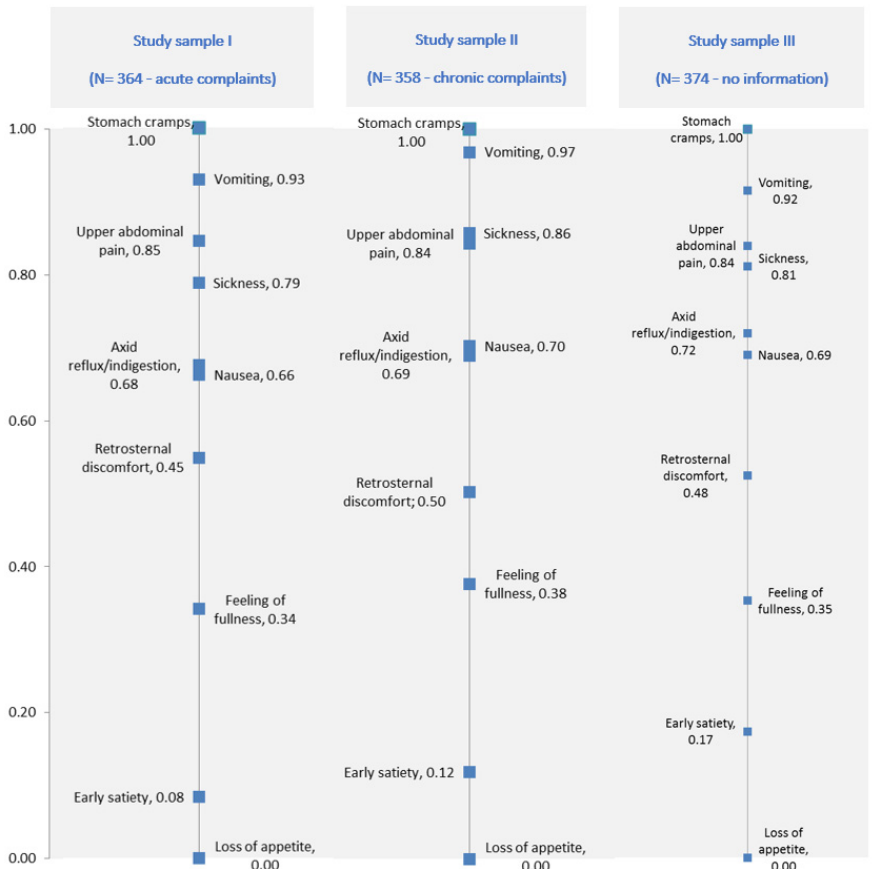
Figure 2. Weighting of gastrointestinal symptoms separated for each study sample.